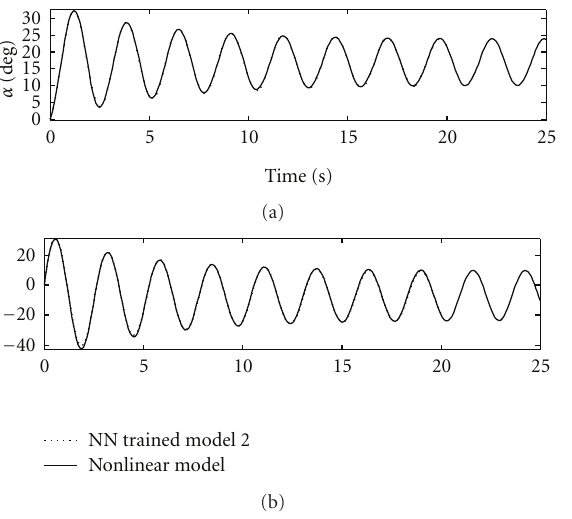
Figure 8: NN trained model 2 versus nonlinear model for generic fighter dynamics.